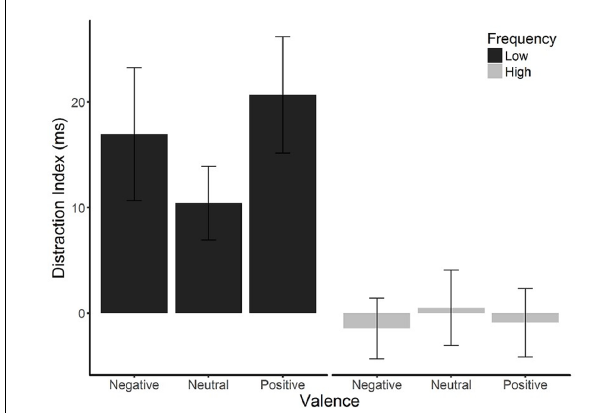
FIGURE 2 | Mean distraction indices (RT on distractor-present trials − RT on distractor-absent trials) by distractor frequency and valence. Emotional distraction was observed in the low distractor frequency condition but not the high distractor frequency condition. Error bars are SEMs corrected for within-subjects comparisons (Morey,